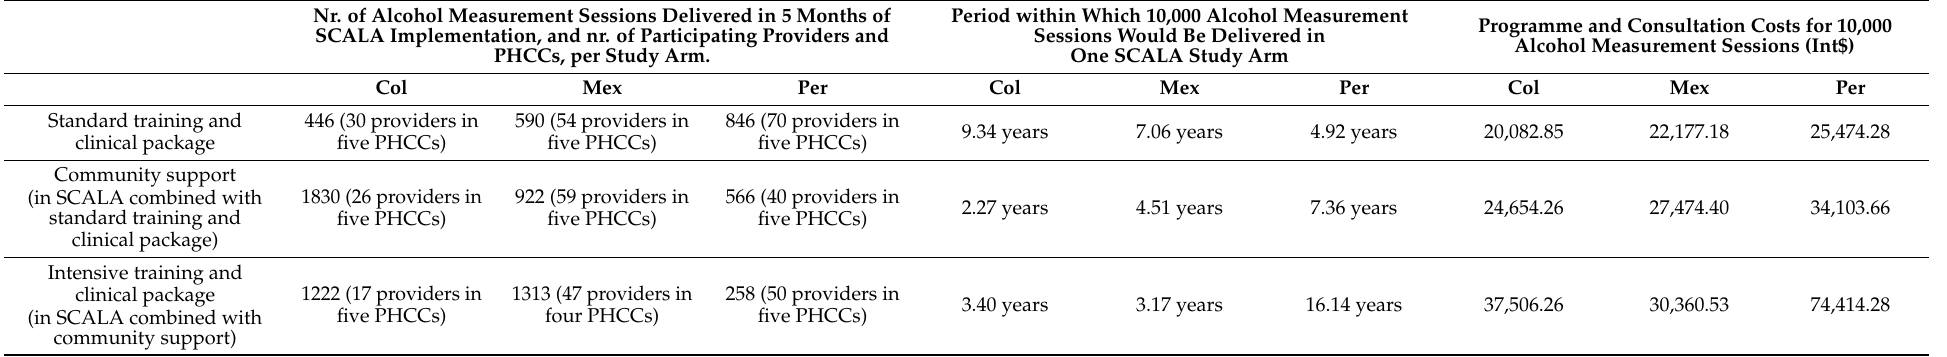
Table 2. Estimated costs per 10,000 patients whose alcohol consumption would be measured in one study